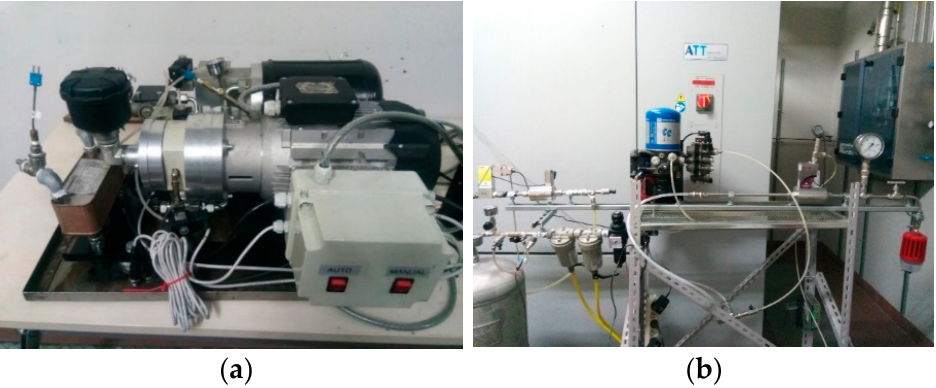
Figure 2. The experimental rig: ( a ) the air compressor unit to be placed inside the climatic chamber;